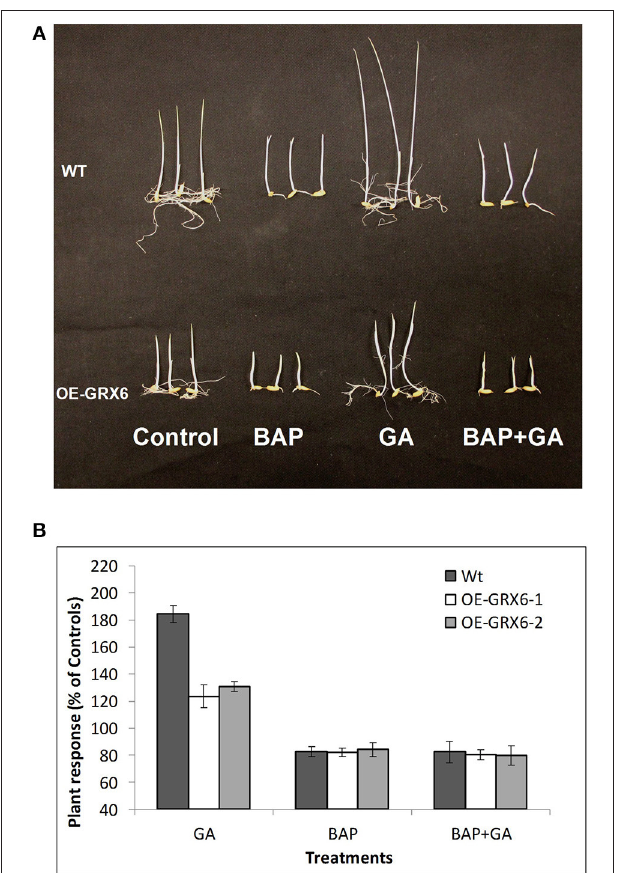
FIGURE 6 | Photochemical quantum yield of Photosystem II (PS II) of OsGRX6 transgenic and wild type plants measured using Pulse-Amplitude Modulated (PAM) photometry. There is a significant increase in the Photosystem II activity or photochemical quantum yield of plants in both transgenic lines compared to the wild type at all stages of growth. Data are means ± SD of four replicates. Asterisks indicate significant differences at P ≤ 0.05 level for each growth stage.